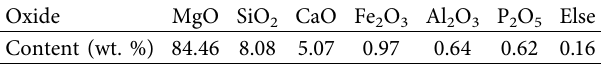
Table 1: Chemical composition of MgO.